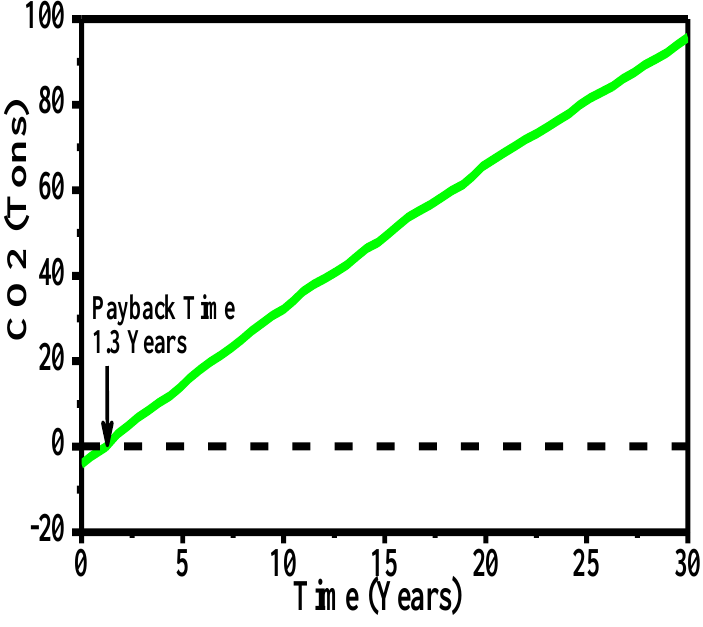
Figure 12: Carbon dioxide saving for [T(30, A(0)] configuration over a span of 30